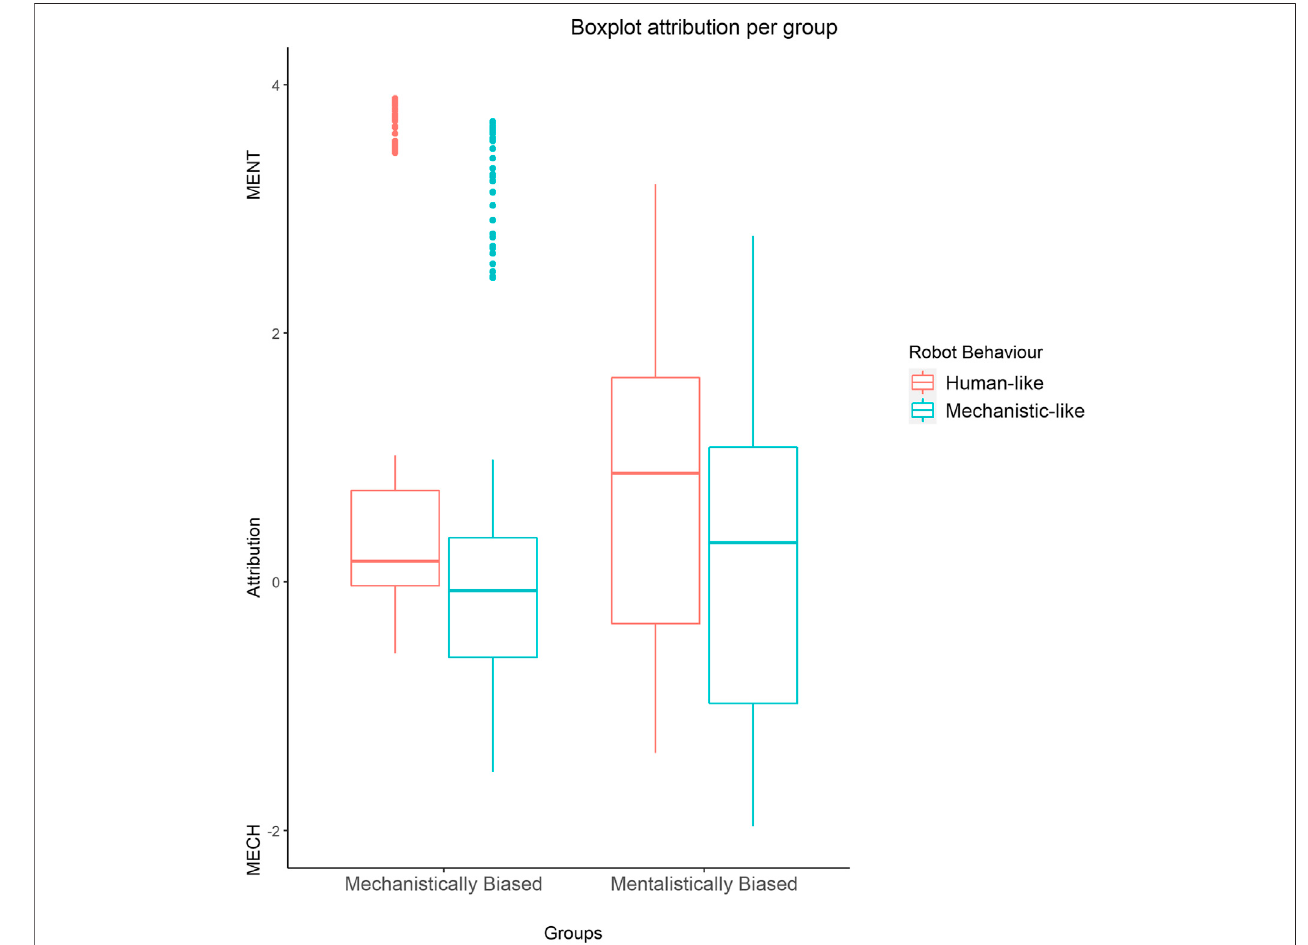
FIGURE 3 | GLMM: boxplot showing the statistically signi fi cant effect of RobotBehaviour * Bias on attribution, with extreme values as predicted by the model.